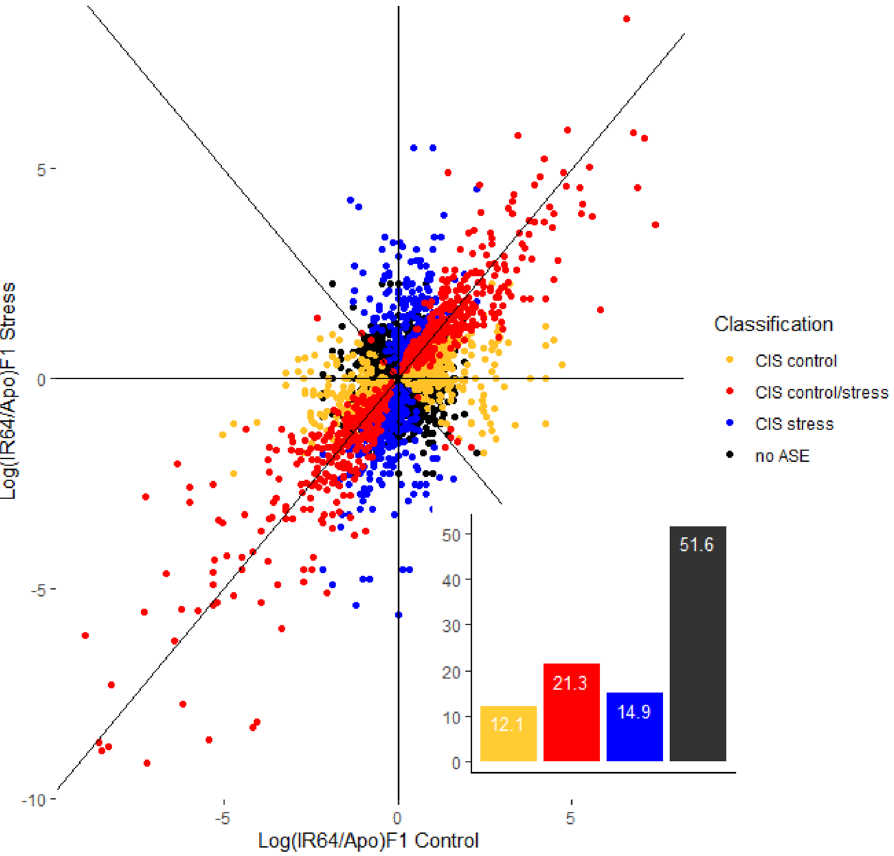
Figure 3. Relative expression ratios between IR64- and Apo-specific alleles in the F1 (Log 2 IR64 F1 /Apo F1 ) under non- (x-axis) and water-stress (y-axis) conditions. Genes are classified based on their CIS category under non- and water-stress conditions (at FDR < 0.5%). Inset bar chart: relative proportion (in percentage) of each CIS category including genes with no ASE classification. Figure generated using ggplot2 (https:// ggplo t2. tidyv erse. org) 23 in R (v 4.0.2 CRAN; https:// www.R- proje ct. org) 24